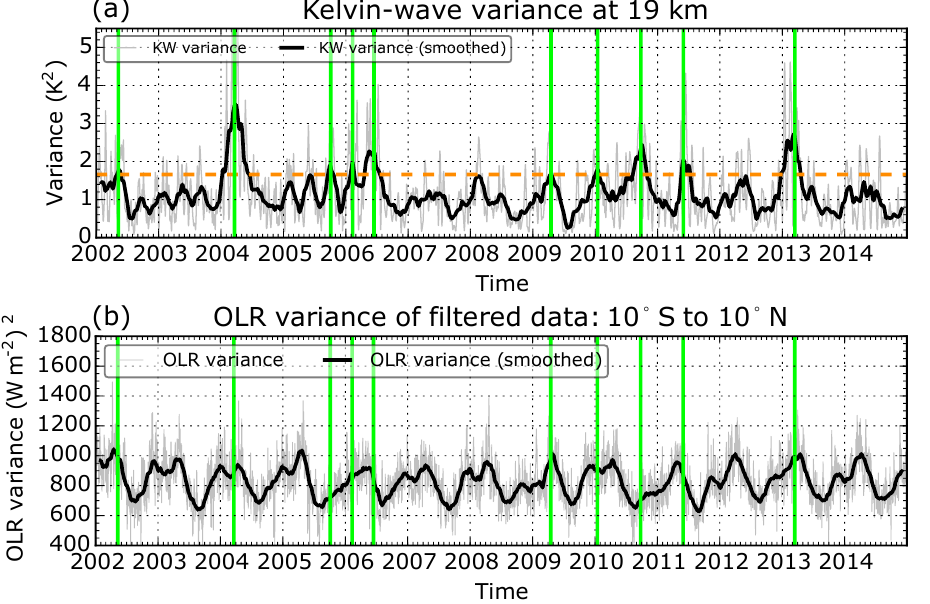
Figure 11. Time series of daily Kelvin-wave variance (thin gray) and smoothed Kelvin-wave variance (thick black) at 19km (top panel) and time series of daily variances of high-pass-filtered OLR data between 10 ◦ S and 10 ◦ N (bottom panel). Green lines indicate points of time with smoothed Kelvin-wave variance outside of 1 standard deviation (1.66K 2 , indicated by the dashed yellow line).